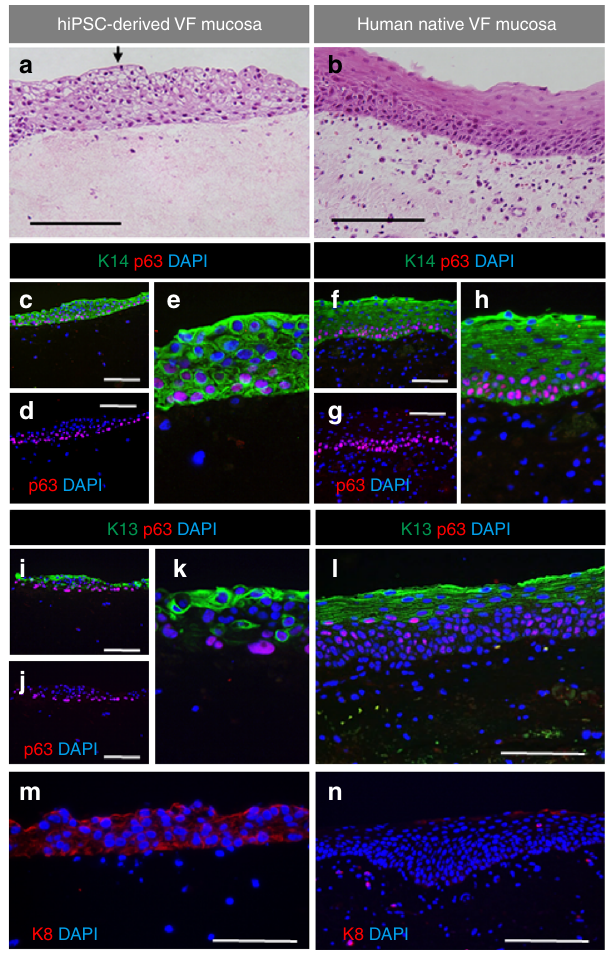
Fig. 6 Pattern of expression of strati fi ed markers in hiPSC-derived VFEC. a , b Hematoxylin – eosin staining showing differences in morphology between hiPSC-derived VFEC ( a ) and human native VF mucosa ( b ). A solid black arrow denotes a fl attened luminal cell layer. c – h Double immuno fl uorescent staining showing expression of Cytokeratin 14 (green) and p63 gene (red) in hiPSC-derived VFEC ( c , e ) and native VF mucosa ( f , h ) and anti-p63 staining showing p63 + basal cells in hiPSC-derived VFEC ( d ) and native VF mucosa ( g ). i – l Double immuno fl uorescent staining showing the expression of Cytokeratin 13 (green) along with p63 (red) in hiPSC-derived VFEC ( i , k ) and native VF mucosa ( l ). j Anti-p63 staining showing p63 + basal cells in hiPSC-derived VFEC. m , n Immuno fl uorescent staining showing pattern of expression of Cytokeratin 8 in hiPSC-derived VFEC ( m ) and human native VF mucosa ( n ). Scale bar = 200 μ m. hiPSC human induced pluripotent stem cell, VF vocal